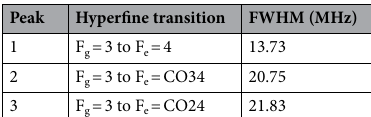
Table 1. Details of the hyperfine transitions observed and their respective linewidth.